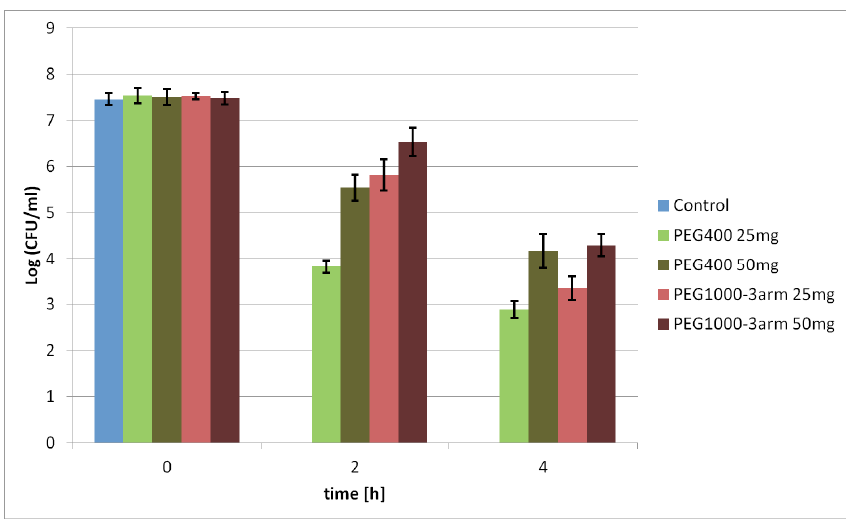
Figure 6. Viability of probiotic bacteria (free cells = control and cells entrapped in γ -PGA-based hydrogels) exposed to pH = 1.5 ( n = 3; error bars, standard deviation).